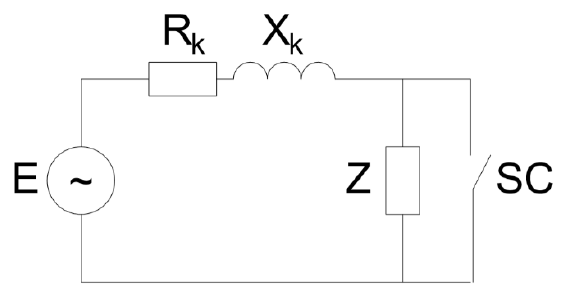
Figure 3. Simplified short-circuit scheme. Figure 3 . Simplified short-circuit scheme.